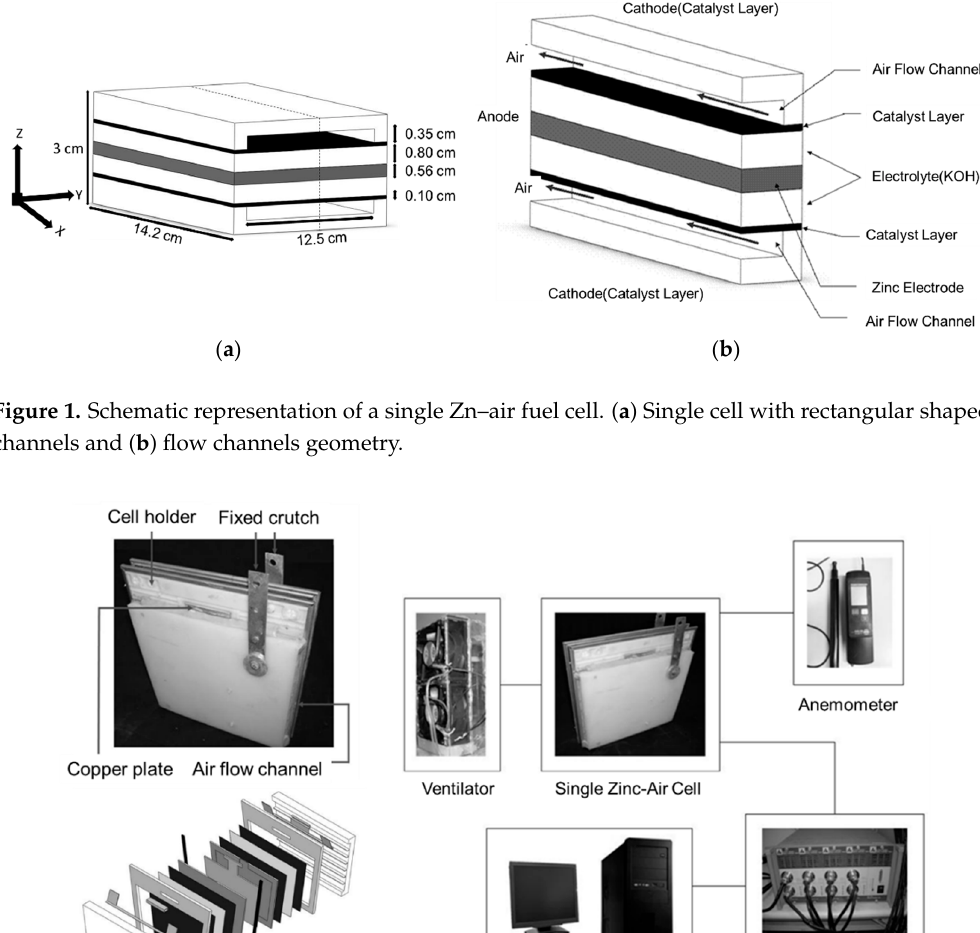
Figure 2. ( a ) Actual Zn–air fuel cell and ( b ) experimental apparatus for performance measurements of a single zinc–air fuel cell.